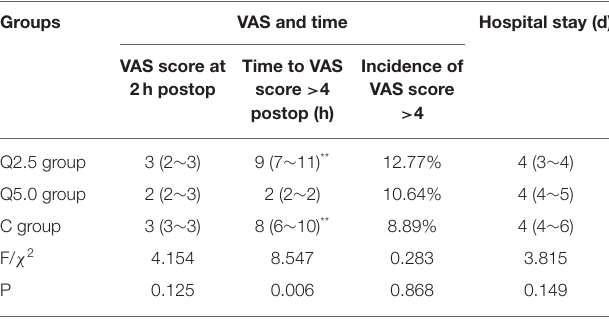
TABLE 2 | Comparison of postoperative pain 2h after surgery and postoperative hospitalization days among the three groups.